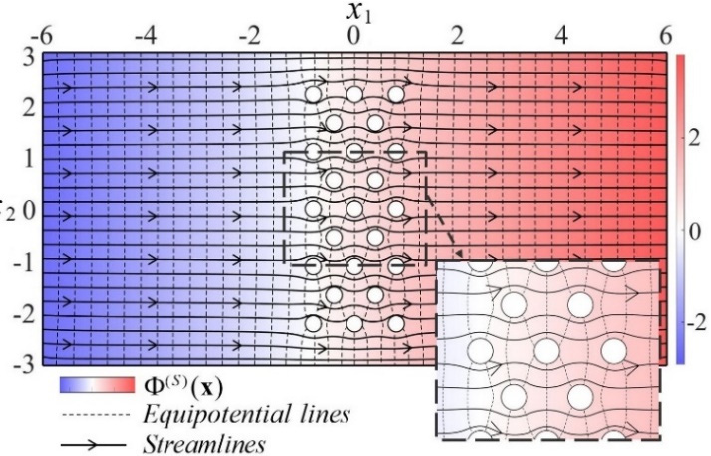
Figure 9. Equipotential lines and streamlines of the steady field resulting from the interaction of a current propagating along the x 1 axis at speed U ∞ = 0.5m/s with a configuration of 23 cylinders of radius a = 0.15m in a 6 m wide tank.